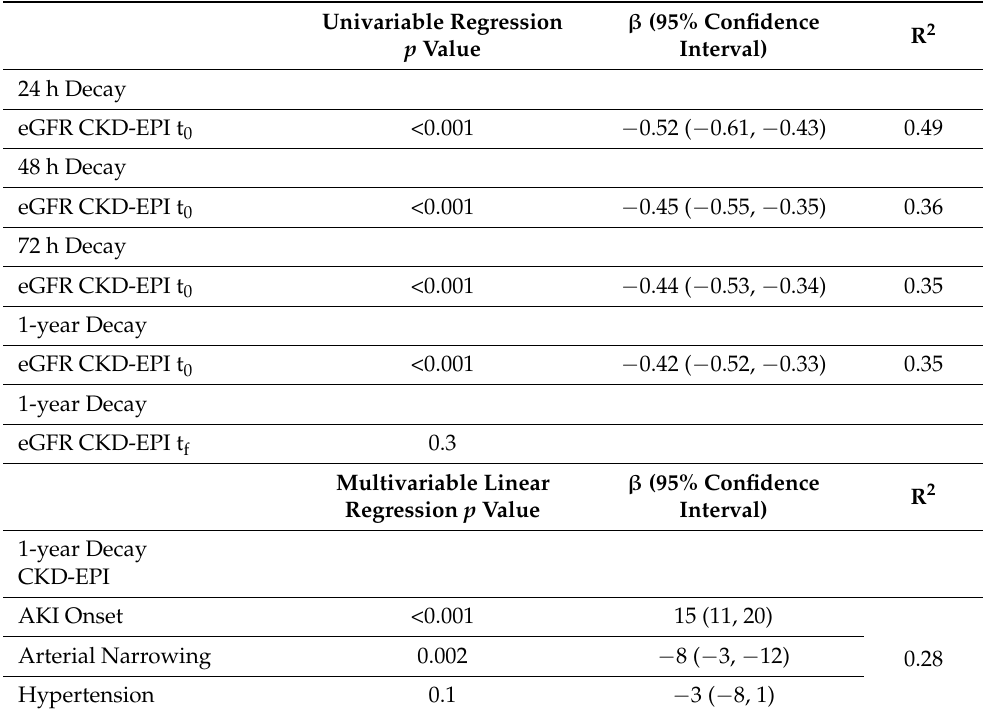
Figure 1. eGFR trend during hospitalization using Loess regression according to AKI onset. Linear regression analysis between the pre-surgery value of eGFR and its decay at 24 h, 48 h, and 72 h exhibited significant results (Table 3). Table 3. Single variable and multivariable linear regression for eGFR decay at 24 h, 48 h, dismissal, and one year after surgery.